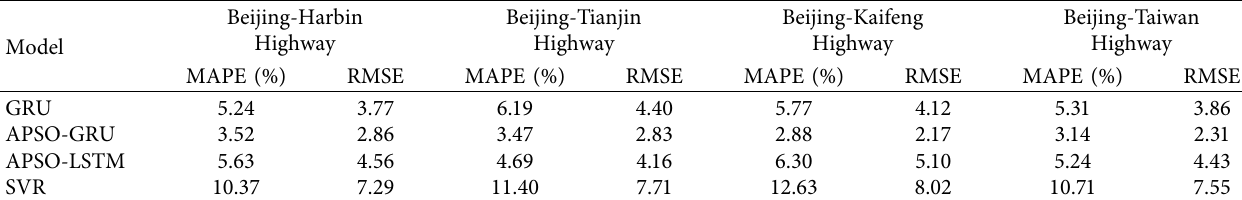
Table 6: Errors in traffic flow speed prediction during sustained rainfall.